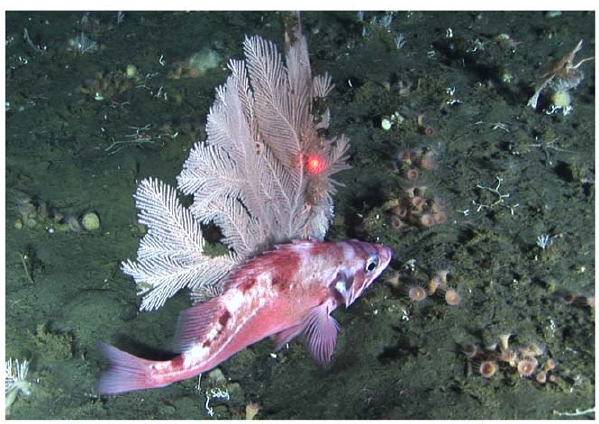
Figure 3. Pacific ocean perch ( Sebastes alutus ) with the gorgonian coral Plumarella sp. at a depth of 230 m in Pribilof